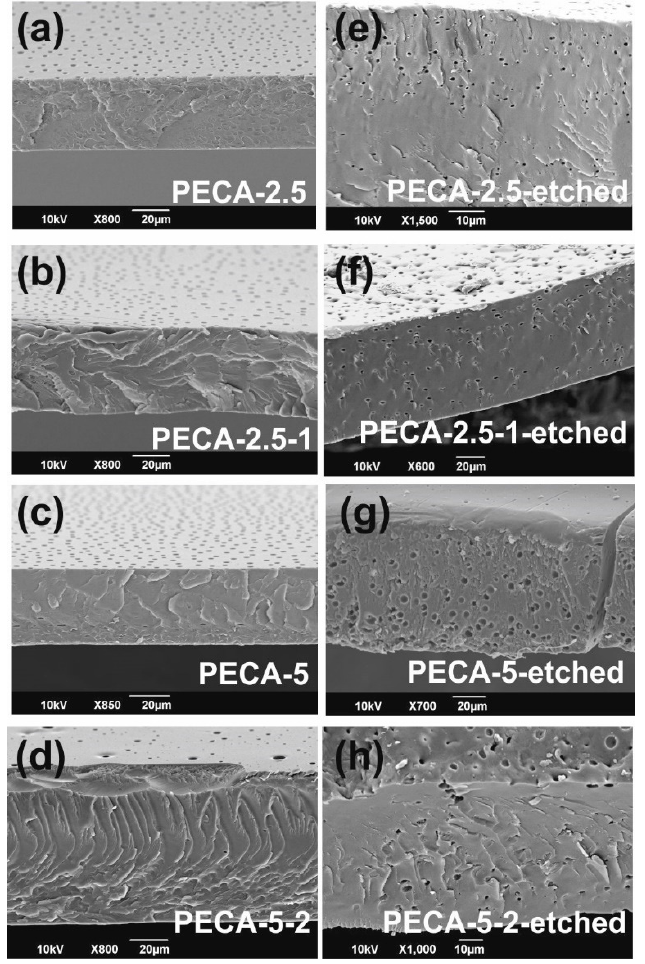
Figure 4. Cross-section SEM images of as-prepared ( a – d ) and solution etched ( e – h ) films. Acetone dissolved away the PPC leaving behind pores similar to the ones observed on the surfaces of the as- prepared films.